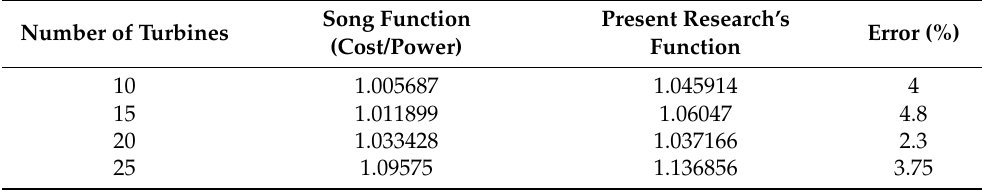
Table 3. The validation of the objective function for cost per power in the first scenario. Song Function Number of Turbines